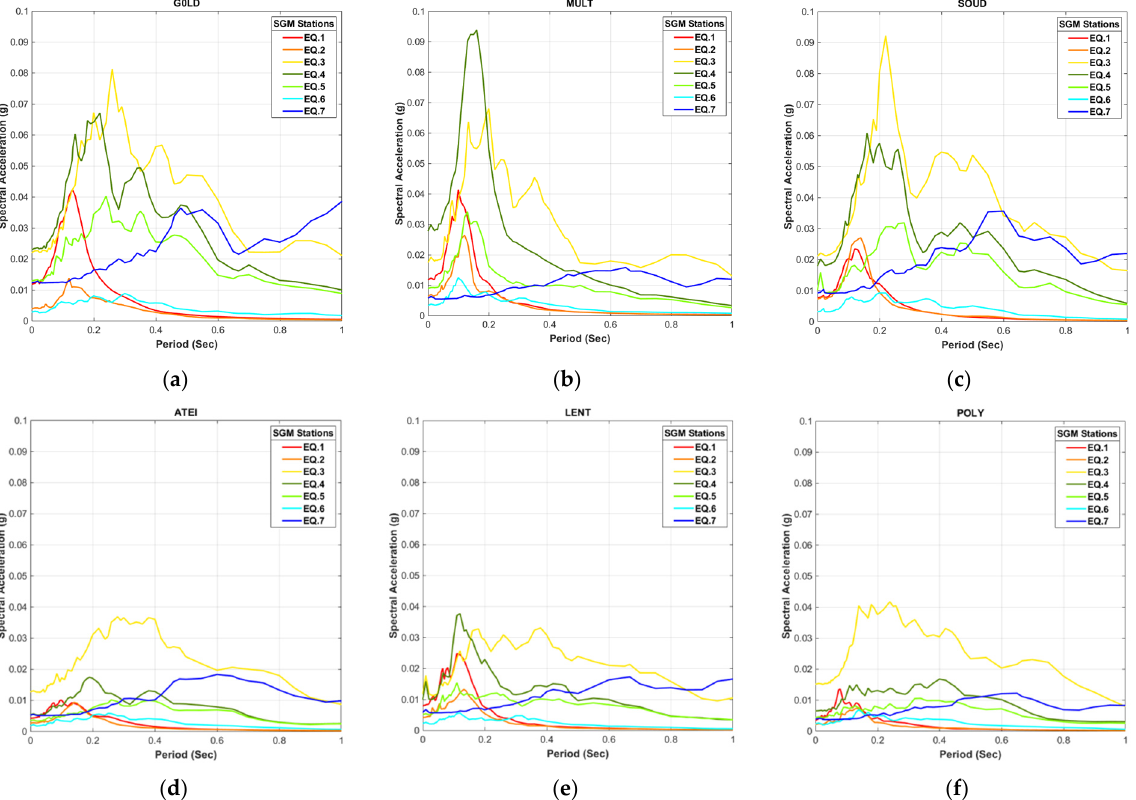
Figure 3. Comparative study of the spectral acceleration values for the same events recorded to selected SGMN stations located on different subsurface geology with contrast of seismic response: ( a ) G0LD-station on Quaternary deposits; ( b ) MULT-station on Neogene marles and Quaternary deposits; ( c ) SOUD-station on loose Quaternary deposits. Stations placed on Neogene limestones: ( d ) ATEI- station; ( e ) LENT-station and ( f ) POLY-station.